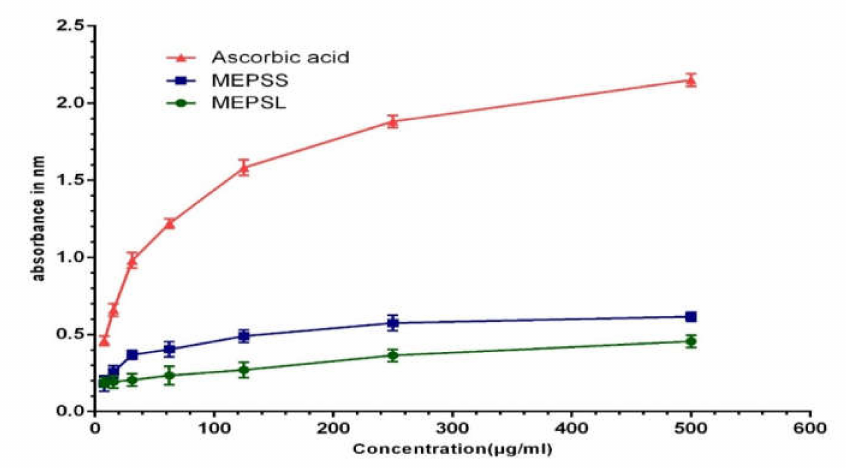
Figure 2. Reducing power capacity of MEPSL and MEPSS compared with the reference standard ascorbic acid. Values are expressed as mean ± SEM ( n = 3). MEPSL, methanol extract of Piper sylvaticum leaves; MEPSS, methanol extract of Piper sylvaticum